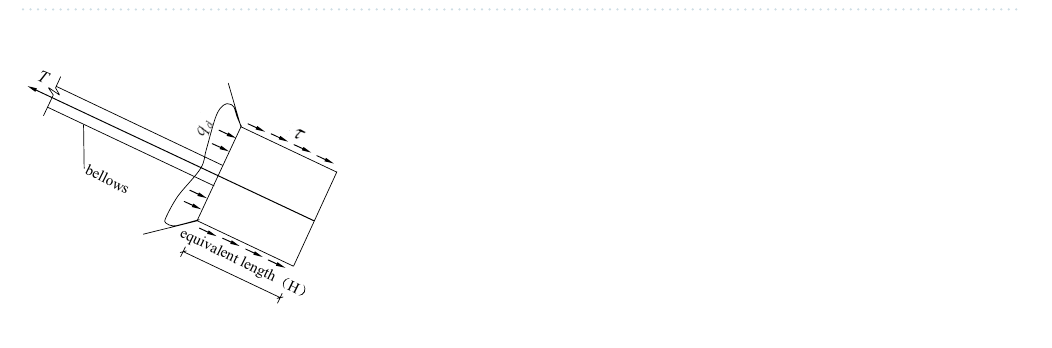
Figure 3. Force diagram of the anchor-pulling system in the phase of transition (emergence of plastic zone).